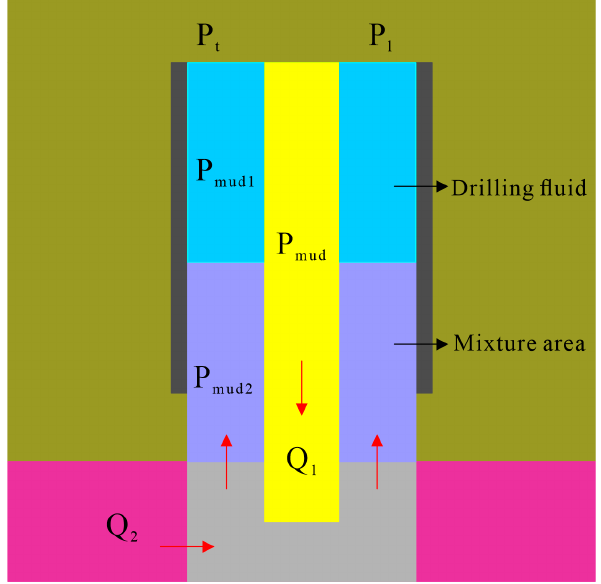
Figure 3. U-tube principle after air gas kick.